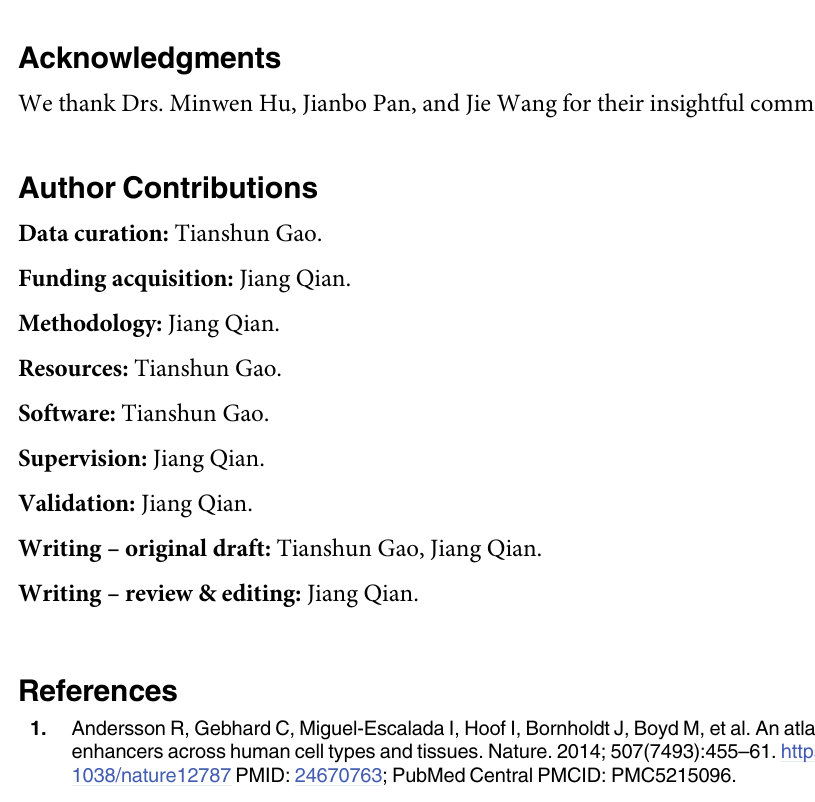
S10 Fig. The correlation between eQTLs and predicted EG interactions by different predic- tion models. The enhancers and expression data in GM12878 were taken as the input. (A) The similar percent (around 11%) of positives and percent (around 0.7%) of negatives in the pre- dicted EG interactions of GM12878 by different models, overlapping with eQTLs in whole blood. (B) The simimar percent (around 11%) of positives overlapping with whole blood eQTLs much higher than that (~7%) in other 47 tissues. S11 Fig. The overview of ensemble boosting algorithm training process. (A) Weak classifier is set to classify all enhancer-gene interaction sites assigned with equal weights in the initial stage. (B)The subsequent classifier keeps track of previous classifier’s errors and starts to dis- tinguish the positives from negatives by randomly increasing positive sites’ weights or decreas- ing negatives’ weights. (C) With utilizing more and more success of previous classifiers, the new generated classifier is trained with a good classification on most sites. (D) The classifier becomes perfect when all sites’ weights are appropriately changed. Generally speaking, the boosting algorithm made each classifier trained with taking into account the previous one’s success. In each step of training, the weights of some sites will be redistributed. Specially, mis- classified sites will change its weights to emphasize their difficulties. Then subsequent new classifiers will focus on them during the new training. S1 Table. Summary of datasets collected for mouse enhancers in 156 tissue/cell types. Each tissue/cell type has at least three tracks and each enhancer is supported by at least one half of the tracks in the relative tissue/cell type.